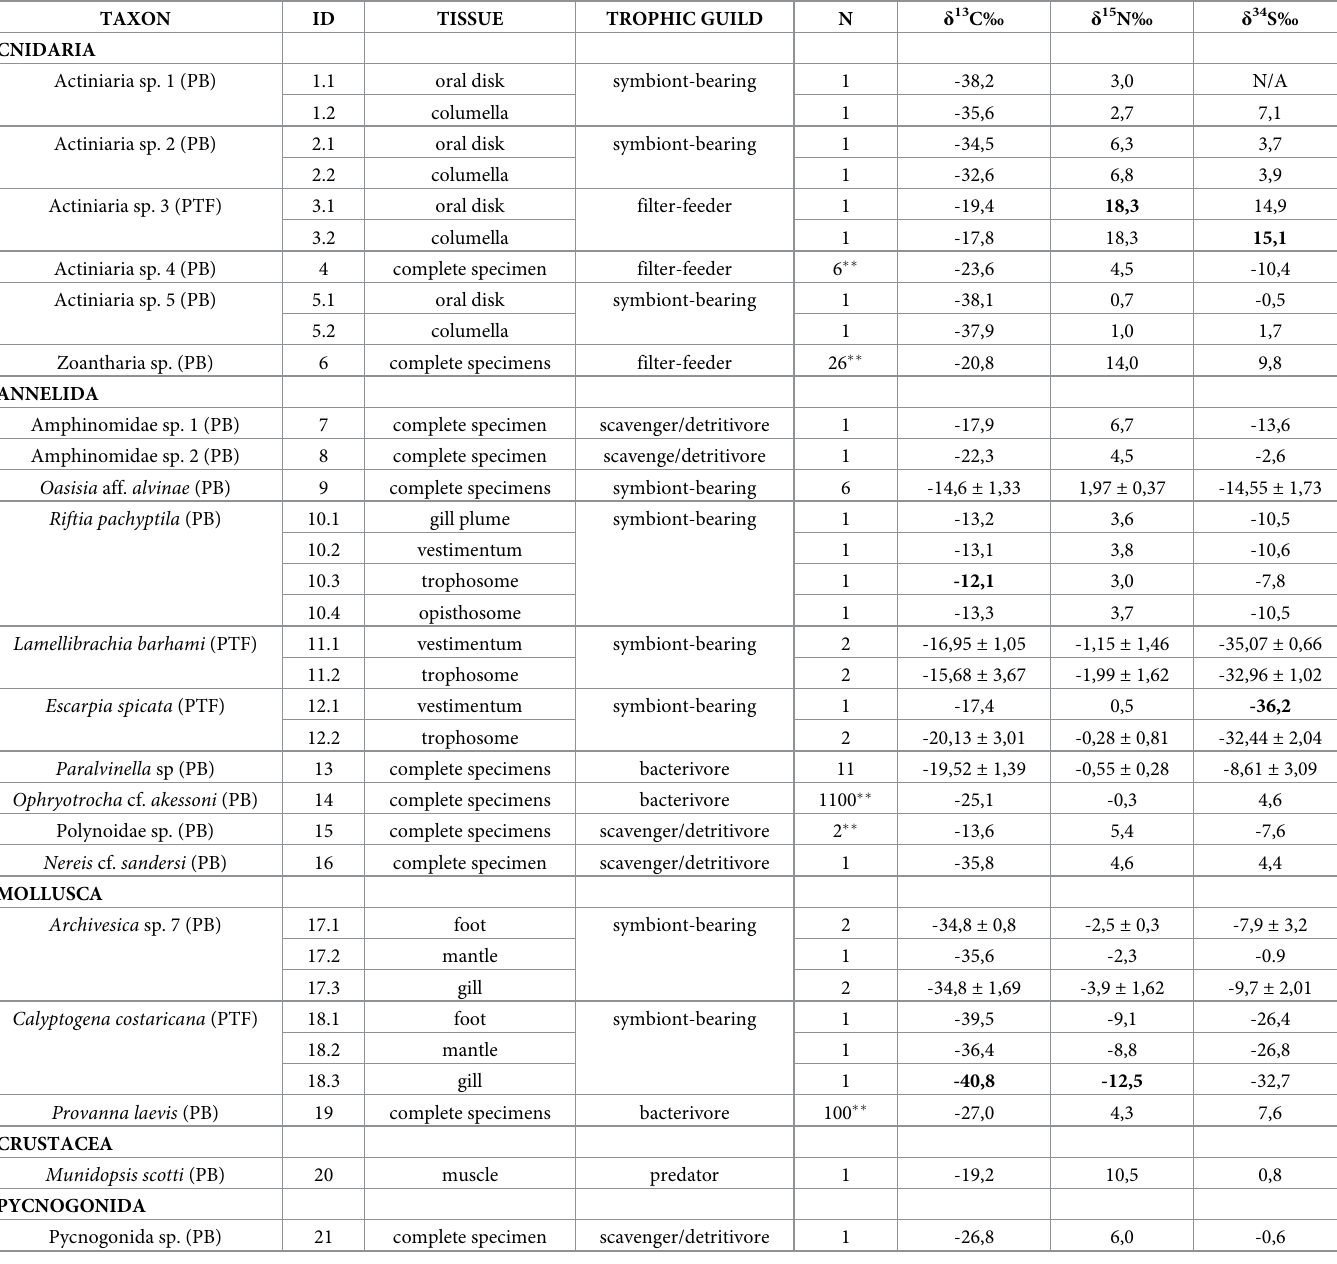
Table 1. δ 13 C, δ 15 N, and δ 34 S individual or average values of the vent and non-vent fauna from Pescadero Basin (PB) and Pescadero Transform Fault